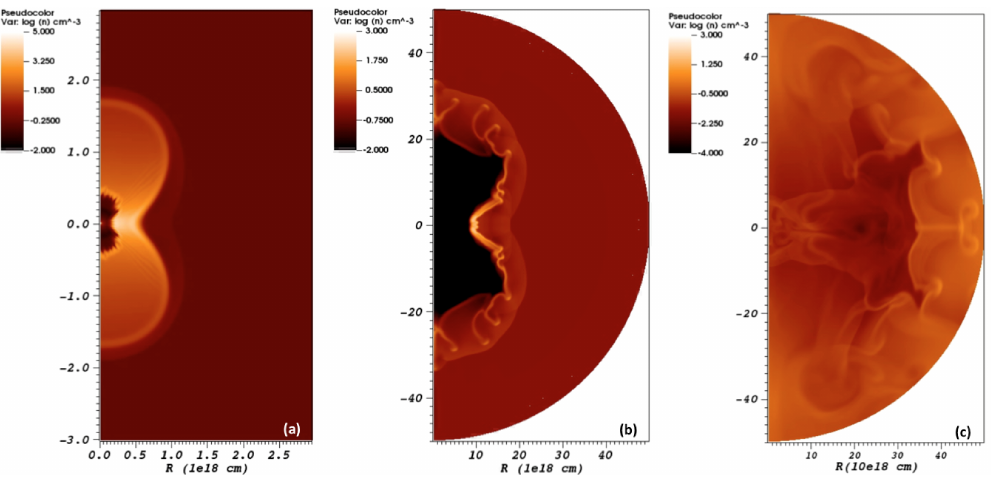
Figure 1. The 2D density contours of the CSM shaped by a bipolar PN for the cases where the SN Ia explosion occurred right after the cessation of the fast wind ( a ), 2 Myr later ( b ) and 8 Myr later ( c